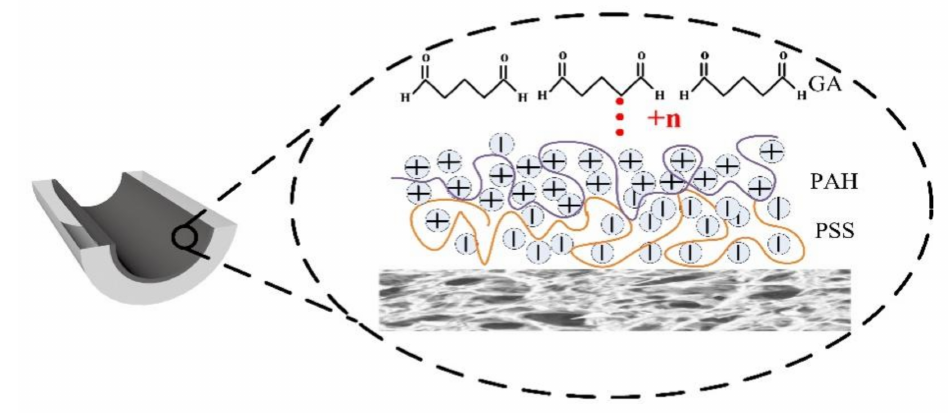
Figure 1. Schematic drawing of NF hollow fiber membrane prepared by LBL method.